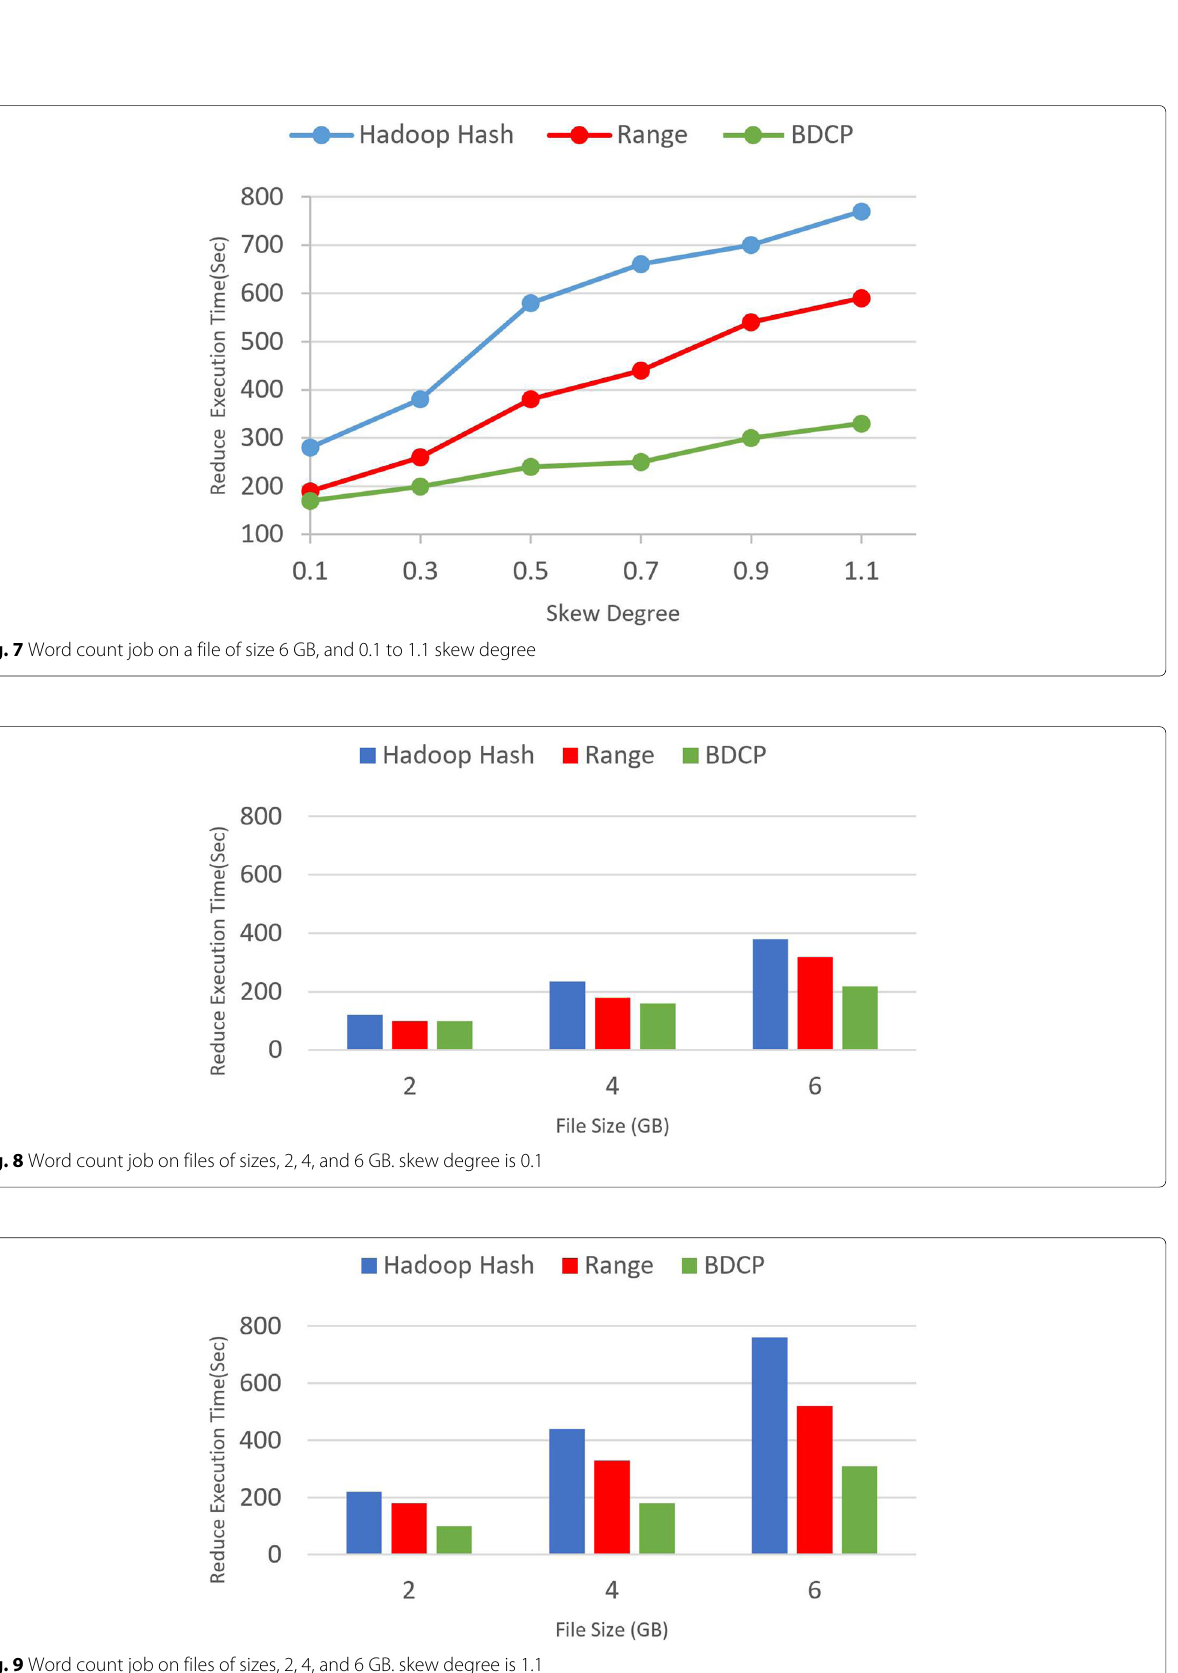
Fig. 9 Word count job on files of sizes, 2, 4, and 6 GB. skew degree is